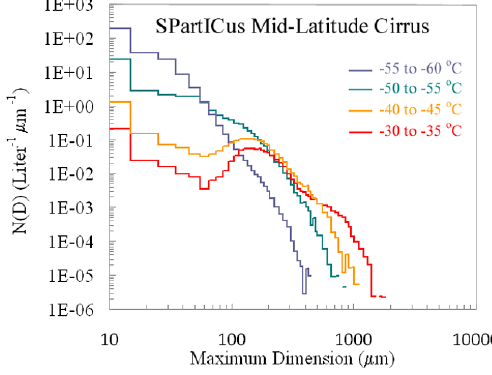
Figure 3. An example of typical PSDs observed in moderately deep SPartICus cirrus clouds Fig. 3. An example of typical PSDs observed in moderately deep observed on 27 January and 10 February 2010. SPartICus cirrus clouds observed on 27 January and 10 February